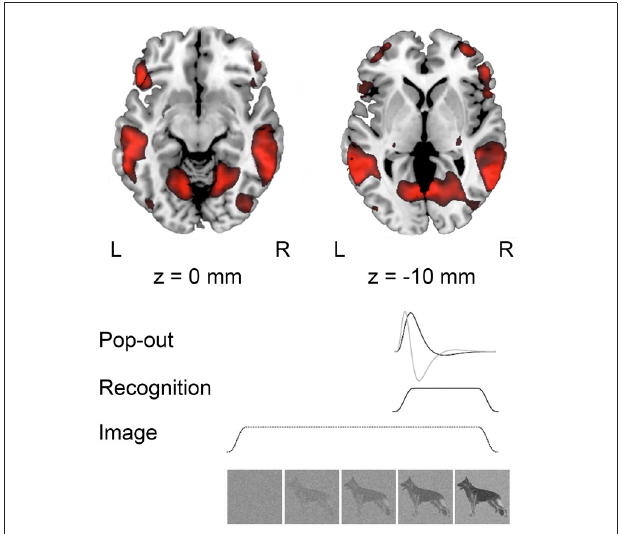
FIGURE 2 | Group activations ( n = 13 ) during recognition at p < 0.001 , uncorrected projected on a standard template in MNI space. Below a schematic representation of the modeled responses during image presentation; “Pop-out” indicating the moment of recognition, “Recognition” modeled from pop-out to the end of the trial and “Image” modeling the whole